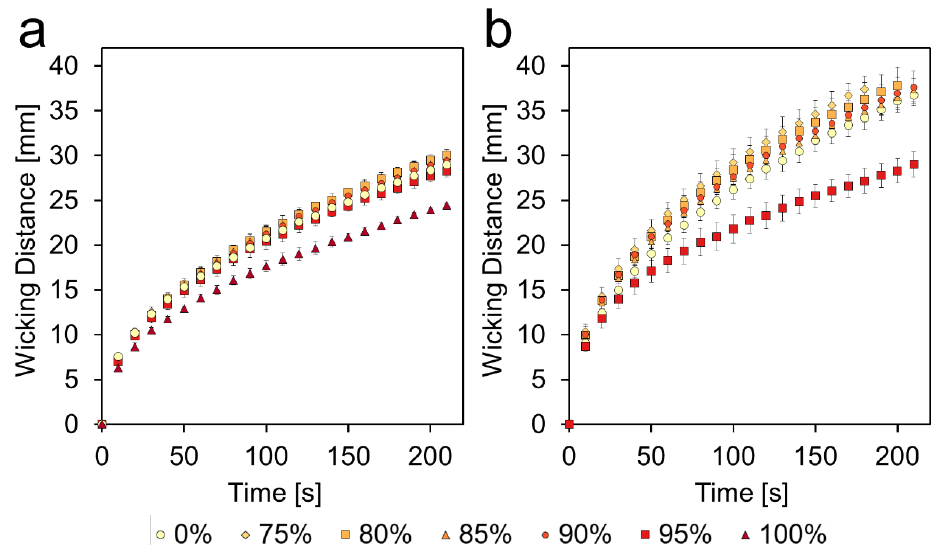
Figure 4. Wicking performance of single- and double-sided etched channels. ( a ) Average wicking distance vs. time at each etching level of single-sided etched paper. ( b ) Average wicking distance vs. time at each etching level of double-sided etched paper. Wicking was performed at 55% relative humidity and constant 23 °C. Data presented as mean ± SD. n = 3.